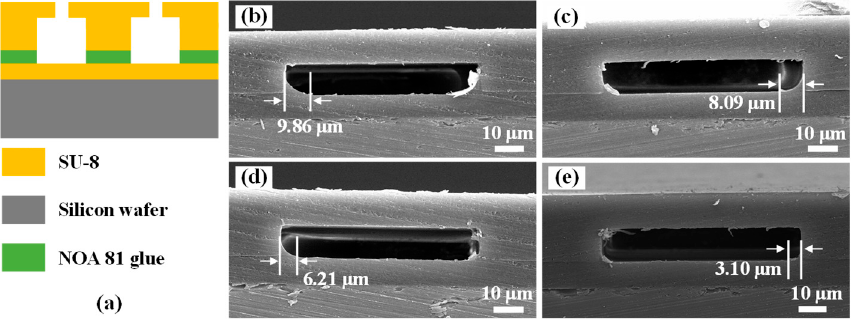
Figure 6. ( a ) The schematic diagram of cross-sections of test samples; SEM images of cross-sections of test samples exposed at various exposure doses: ( b ) 260 mJ/cm 2 ; ( c ) 280 mJ/cm 2 ; ( d ) 300 mJ/cm 2 ; and ( e ) 320 mJ/cm 2 .